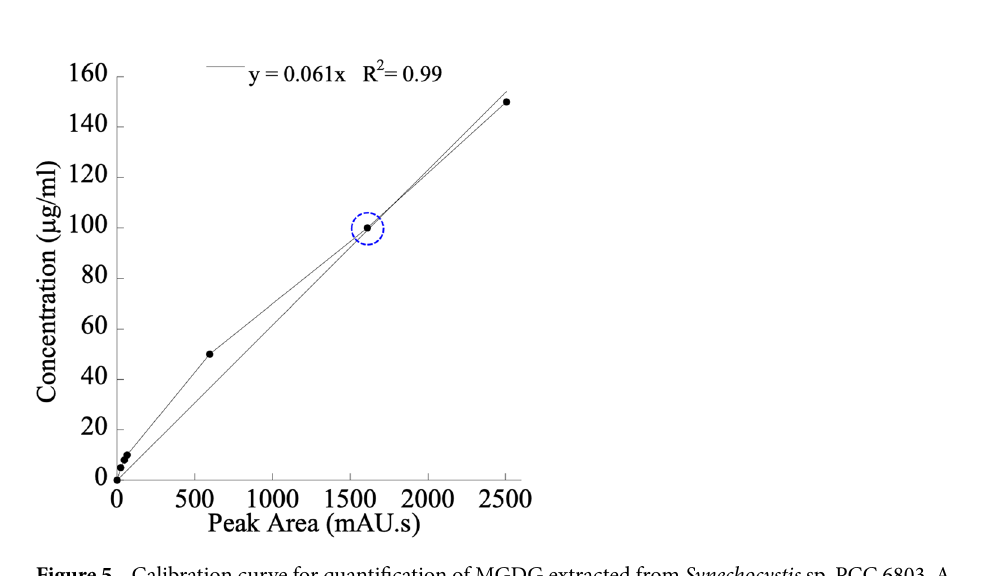
Figure 5. Calibration curve for quantification of MGDG extracted from Synechocystis sp. PCC 6803. A standard calibration curve was prepared using known concentrations of plant extract MGDG molecule and the corresponding peak areas in terms of milli-absorbance unit × seconds (mAu.s) in HPLC–UV analysis. The equation obtained for the unknown concentration of the MGDG molecule for any known peak area is y = 0.061 × with the R 2 value of